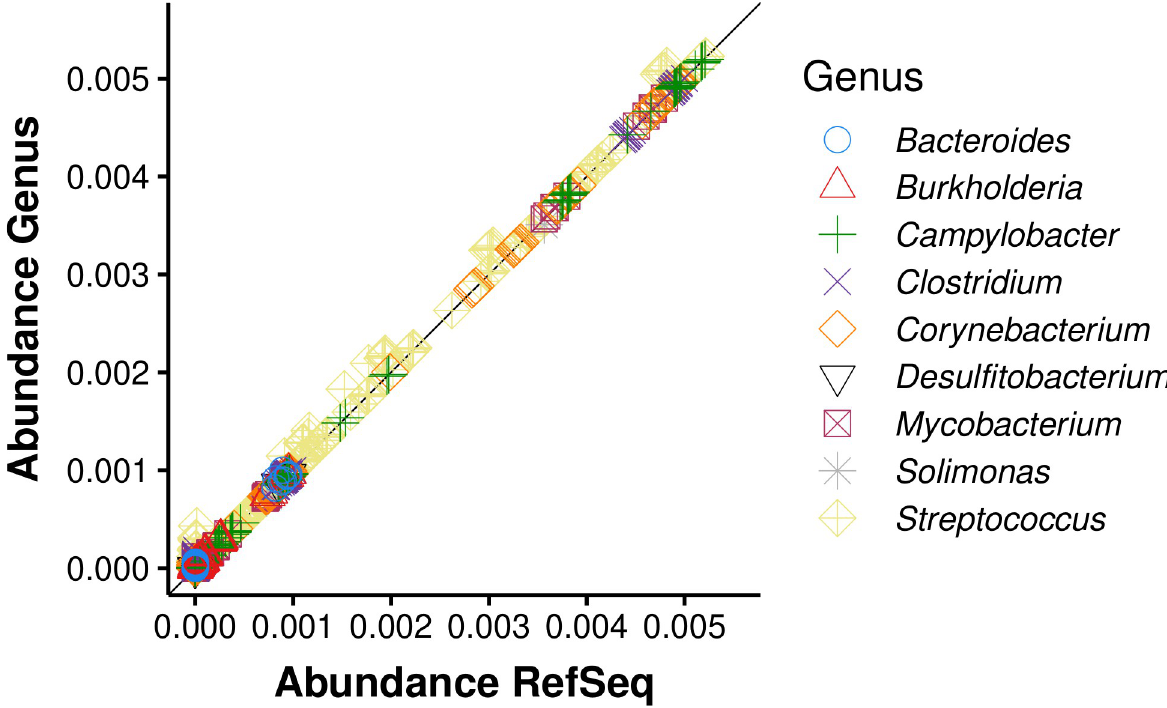
Fig 6. HAYSTAC inferred posterior abundance levels. Scatter plot showing the mean posterior abundances across all taxa ( n = 362) and samples ( n = 20) for either a genus specific database or the entire RefSeq representative database of prokaryotic species. Using a genus specific database has a small positive bias in mean posterior abundance for taxa within that genus (paired t-test p-value < 2.2 � 10 − 16 , mean of the differences = 3.9 � 10 − 6 ), nevertheless the overall abundance levels are highly correlated ( R 2 = 0.999). Computational runtime for the genus specific analyses are faster and use less memory, making genus specific analyses suitable for rapid initial screening (e.g. 1 million reads against a Corynebacterium specific database runs approximately 6.15 faster than against a database containing 500 species and uses approximately 3.9 times less